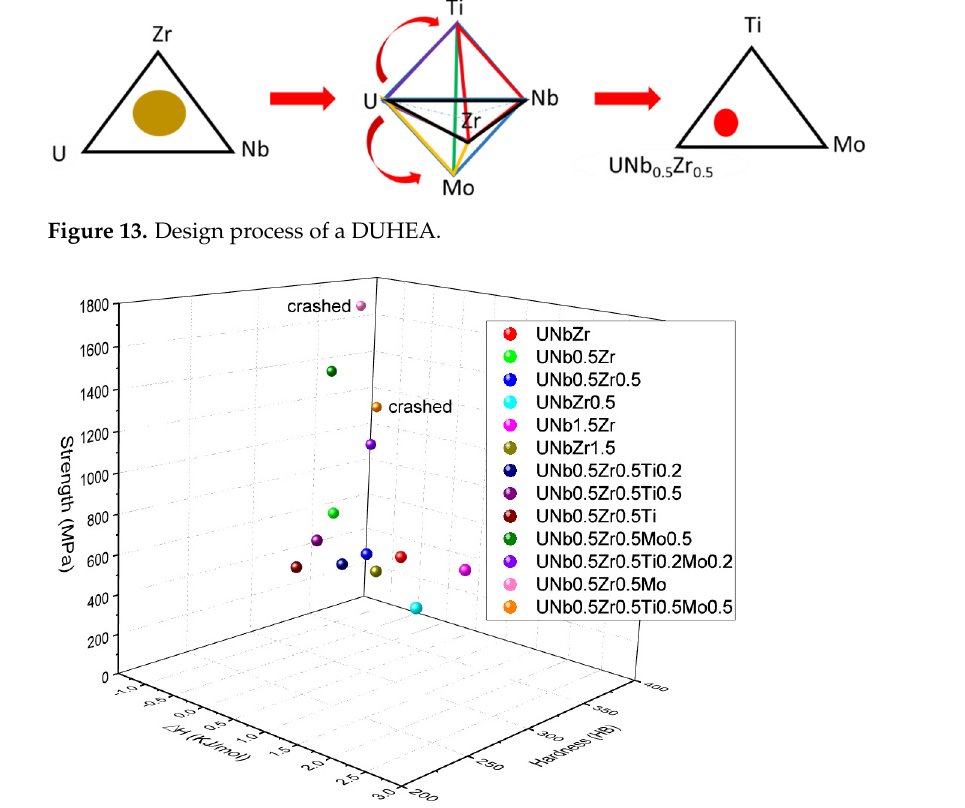
Figure 14. Trend graph of the relationship between the mixed enthalpy and mechanical properties of the U-Nb-Zr-Ti-Mo HEAs.